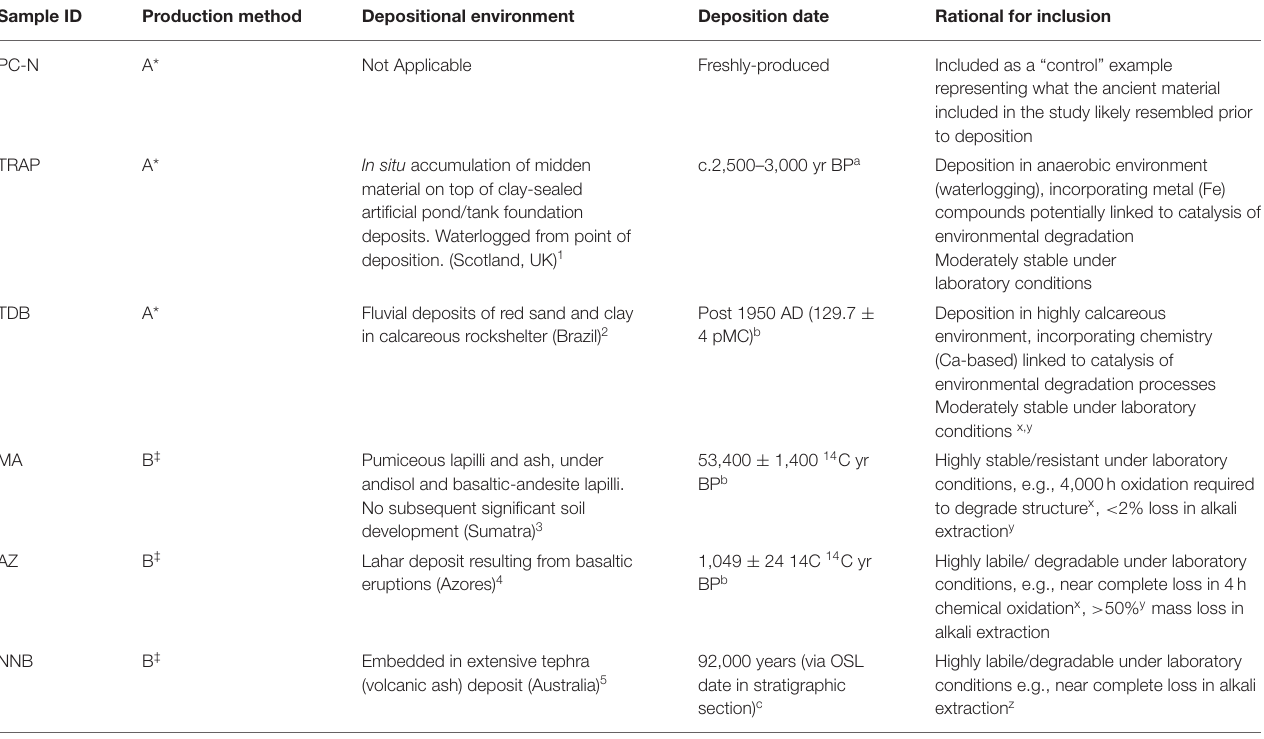
TABLE 1 | Details of sample material used in this study, including production method, depositional environment and